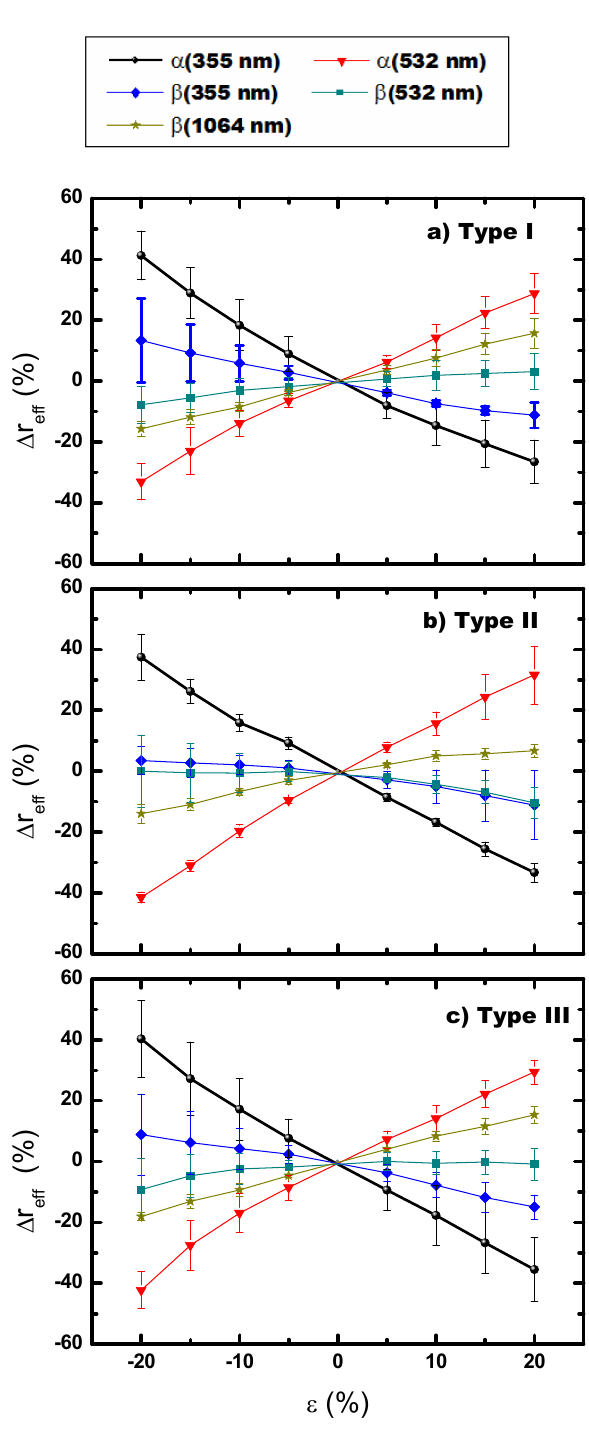
Figure 2: Percentage deviation of the effective radius as a function of systematic bias in the optical data ( ε ). a) Type I. b) Type II. C) Type III.